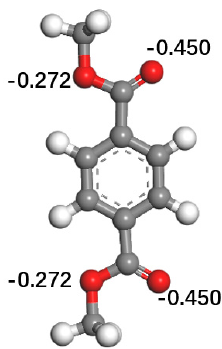
Figure 15. Partial atomic charge of PET molecules.